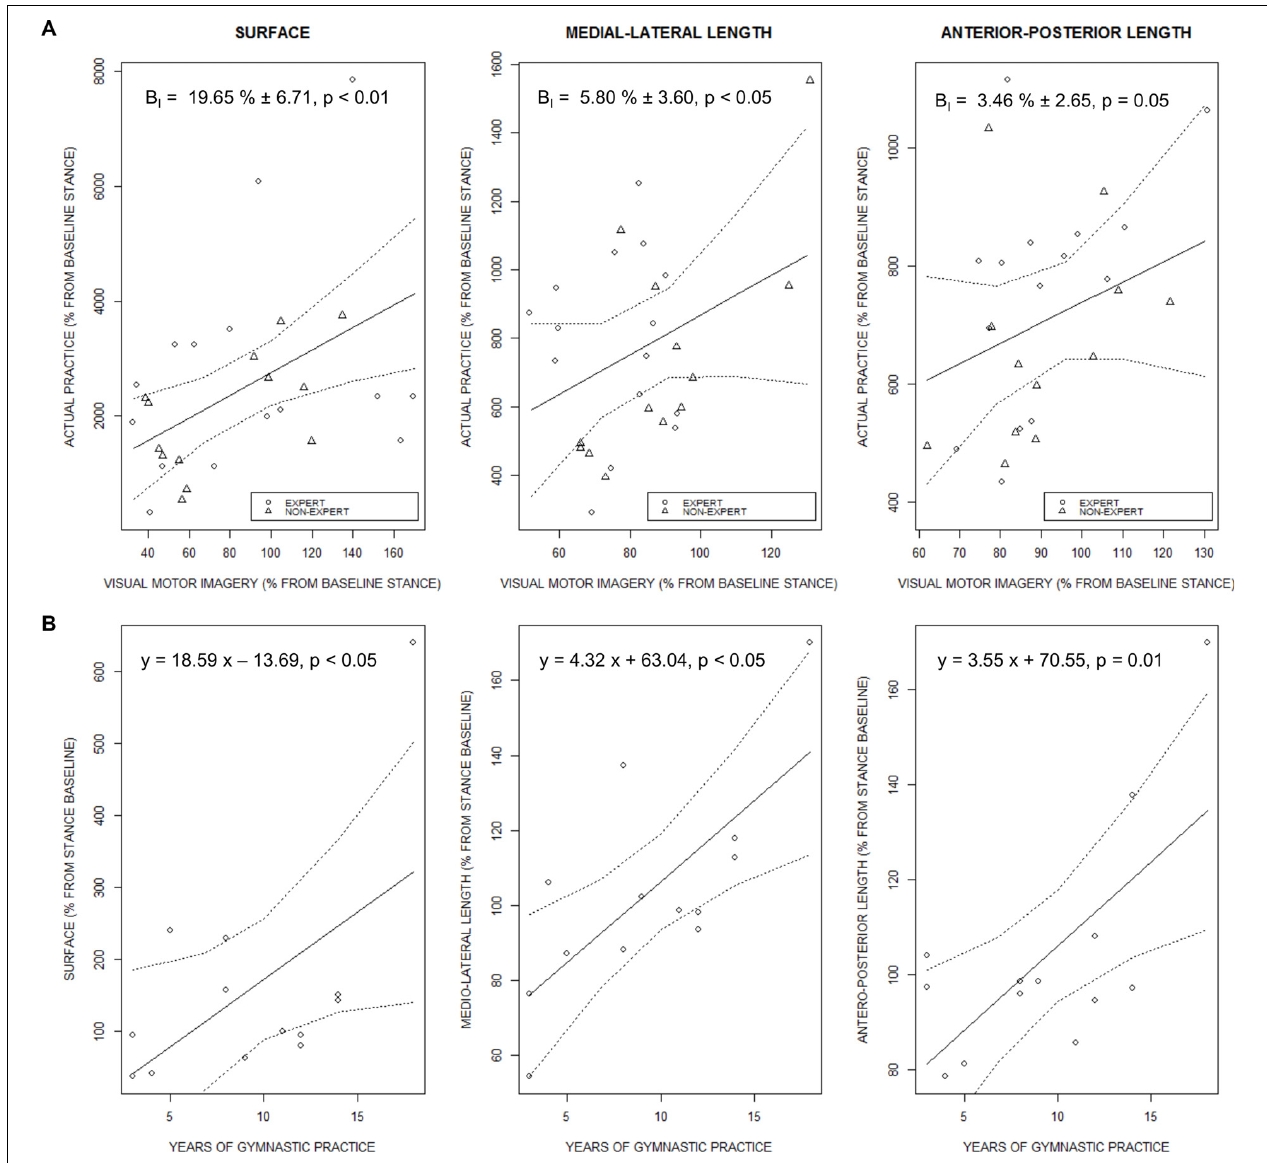
FIGURE 5 | (A) Fitted estimates of the regression analysis carried on variables extracted from stabilometric measures during actual practice of the arabesque variation, using stabilometric measures during VMI as regressor. The regression slope is presented with 95% confidence intervals (dotted lines). (B) Regression slope of the linear model carried on stabilometric variables recorded during KMI and the amount of training practice in